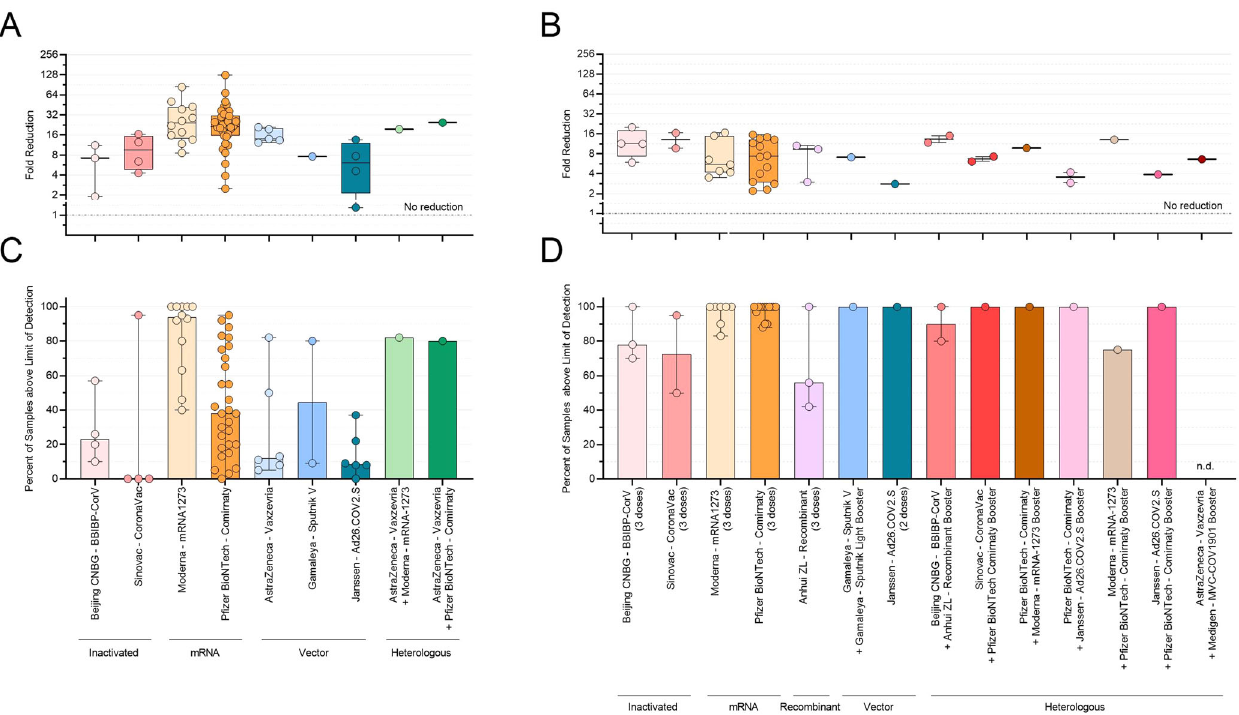
Fig. 1 Primary vaccination series and booster neutralizing ability and percent responders against Omicron. Neutralizing ability of antibodies against Omicron variant by vaccine as measured by A : fold reduction post-primary series vaccination; B : fold reduction post- booster vaccination; C : percent of responders post-primary; D : percent of responders post-booster. Thick lines represent median, thin lines represent interquartile range